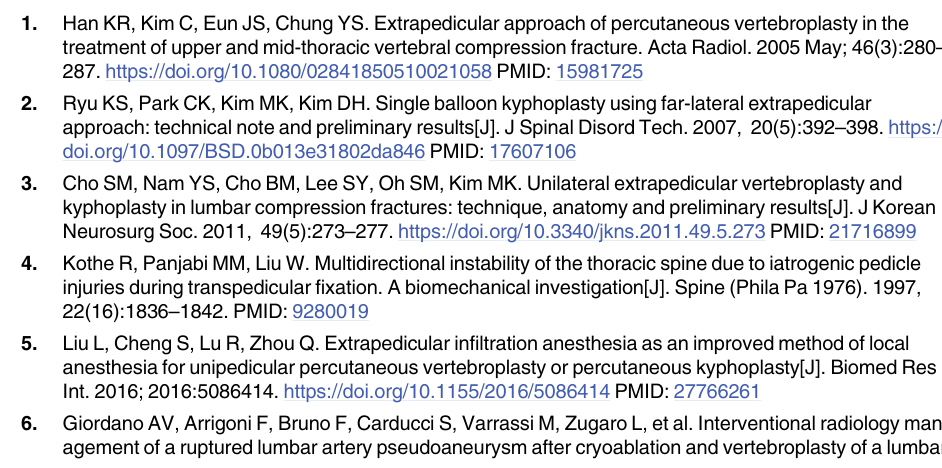
S1 Table. Study data. D data in L1-L5 for each sample. Absence indicates that the LA VBPP-LA was absent. Absence (ISB) indicates that the LA was absent, but there was an intersegmental branch originating from the upper LA. � represents the 5 th LA originated from the iliolumbar artery. # represents the 5 th LA originated from the internal iliac artery. & represents the 5 th LA originated from the common iliac artery. Red table cell: Type I LA; yellow table cell: Type II LA; blue table cell: Type III LA; green table cell: Type IV LA; ISB: Type V LA.